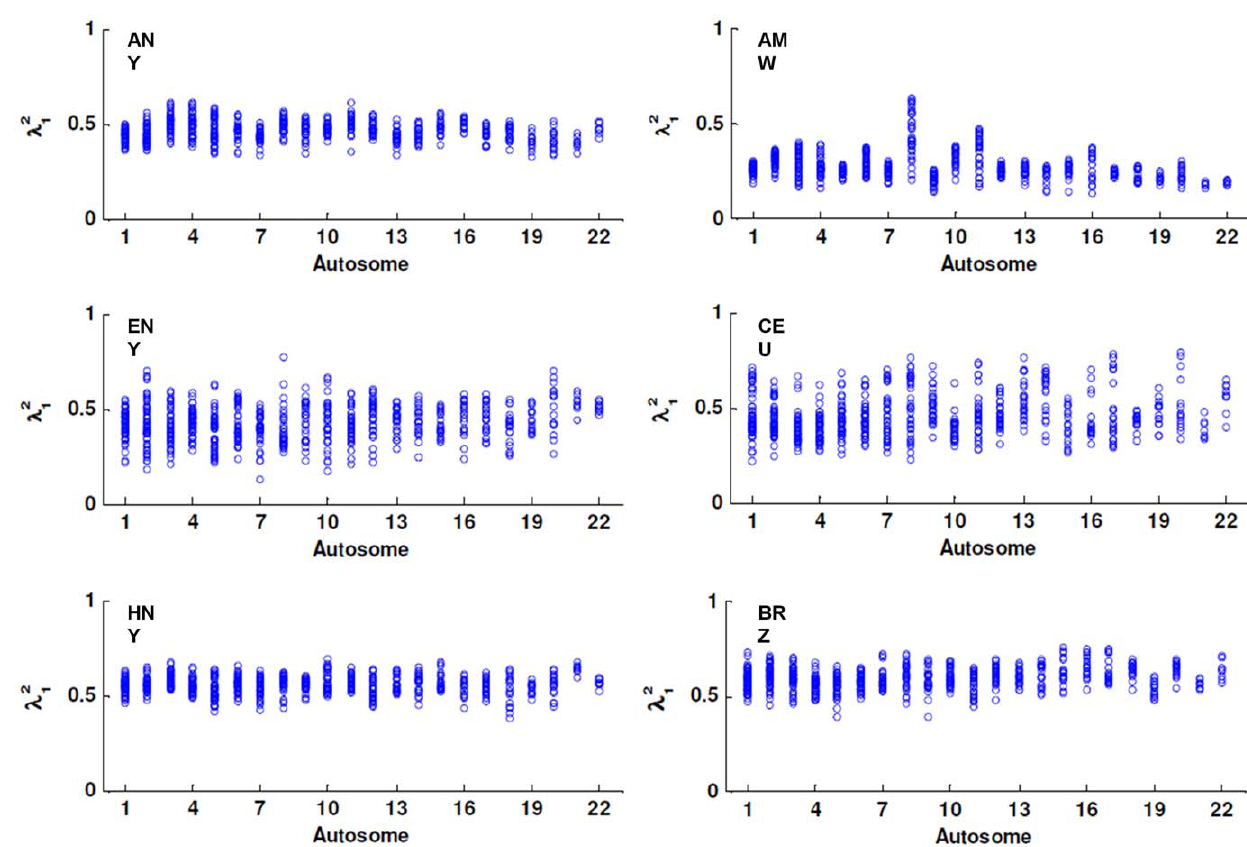
Figure 2. Canonical correlation based on window-wide local PCs for biobank samples and selected external samples. Each circle represents the squared coefficient of the largest canonical correlation between the first 10 local PCs of a local 20 Mb-window and the first 10 global PCs. Abbreviation for samples: African American biobank sample (ANY); European American biobank sample (ENY); Hispanic American biobank sample (HNY); African American from Maywood, Illinois (AMW); CEPH (Utah residents with ancestry from northern and western Europe (CEU); Brazilians from Brazil (BRZ).